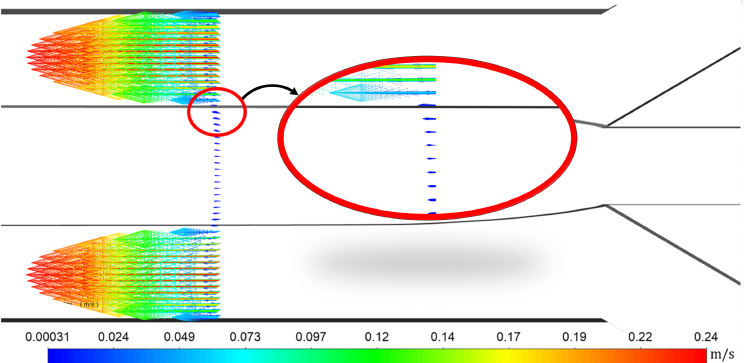
Figure 4. Velocity increasing in the oil phase in the vicinity of the interface.